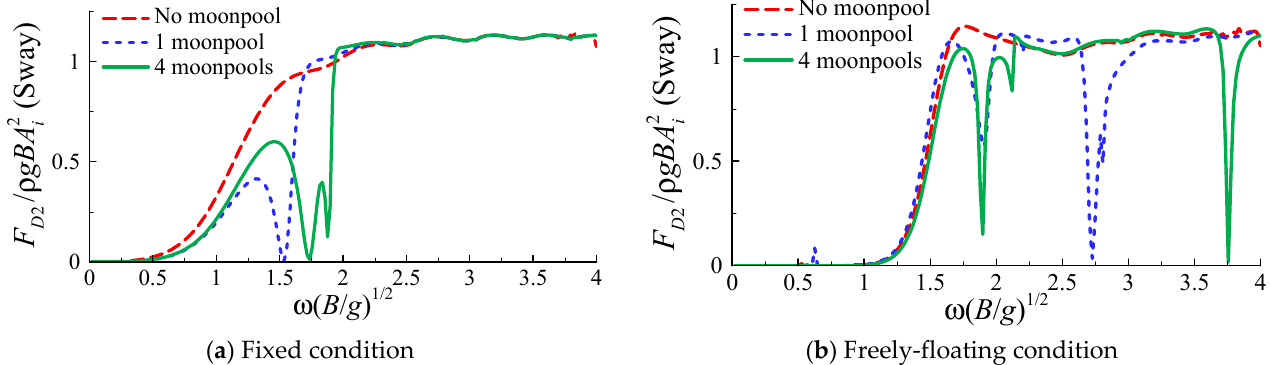
Figure 8. Calculated mean sway drift forces on a barge with/without moonpool(s) in beam waves.